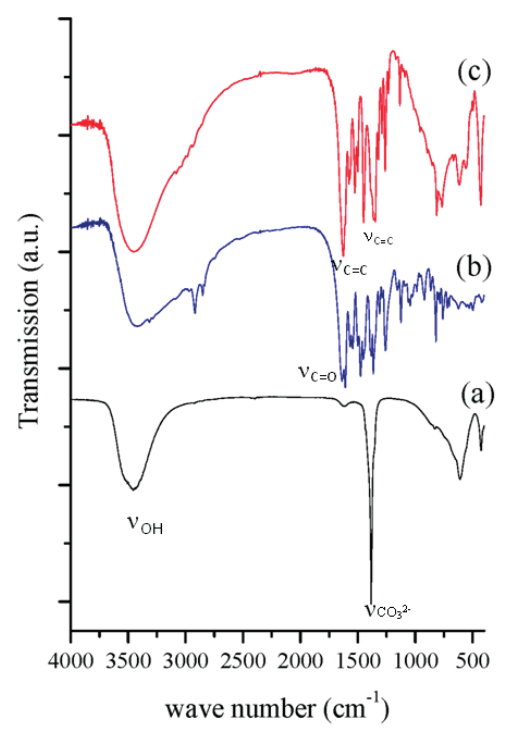
: (a) free of organic biocide, (b) 3